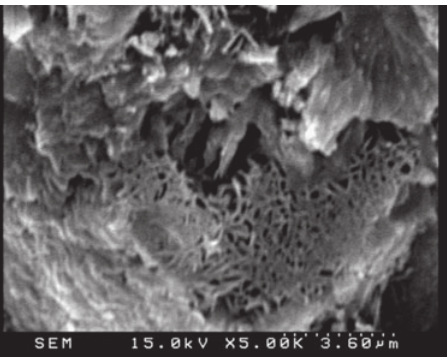
Figure 6 SEM image of specimen without bagasse ash BA0 ( × 5K).